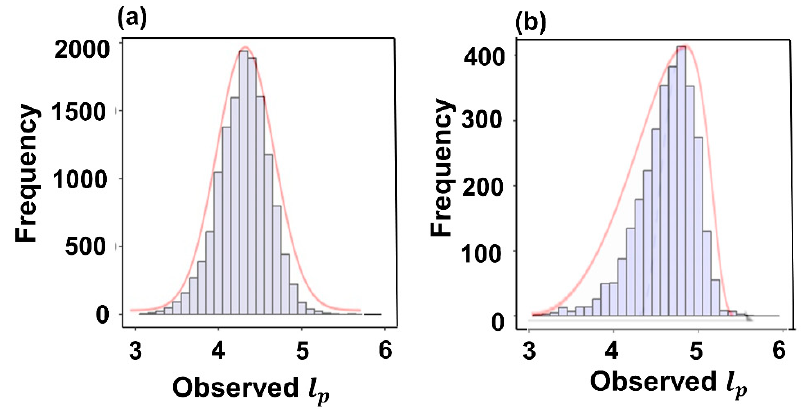
Figure 1. Flowchart representing K-fold model validation.